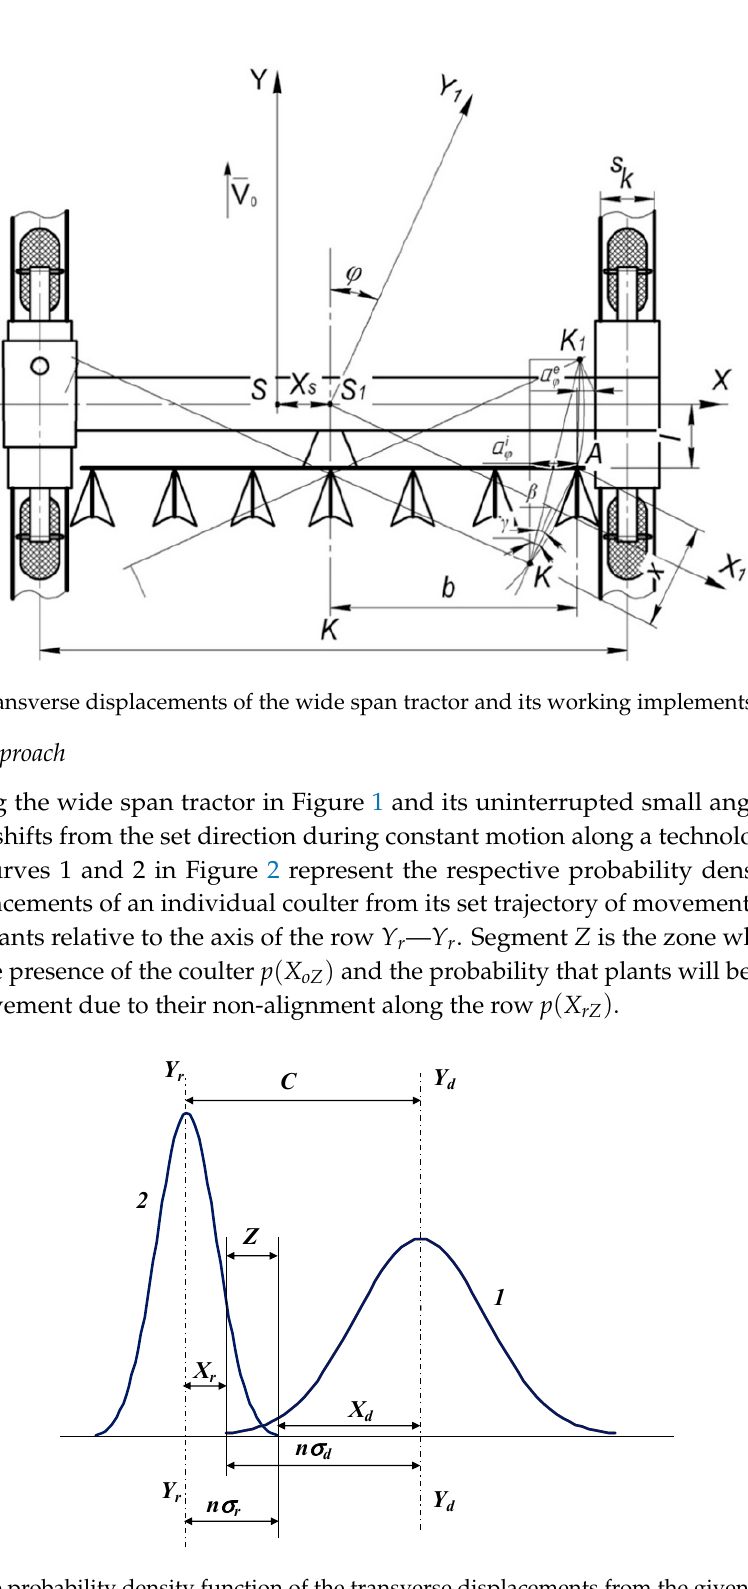
Figure 2. The probability density function of the transverse displacements from the given direction of coulter movement 1 and plant position 2.